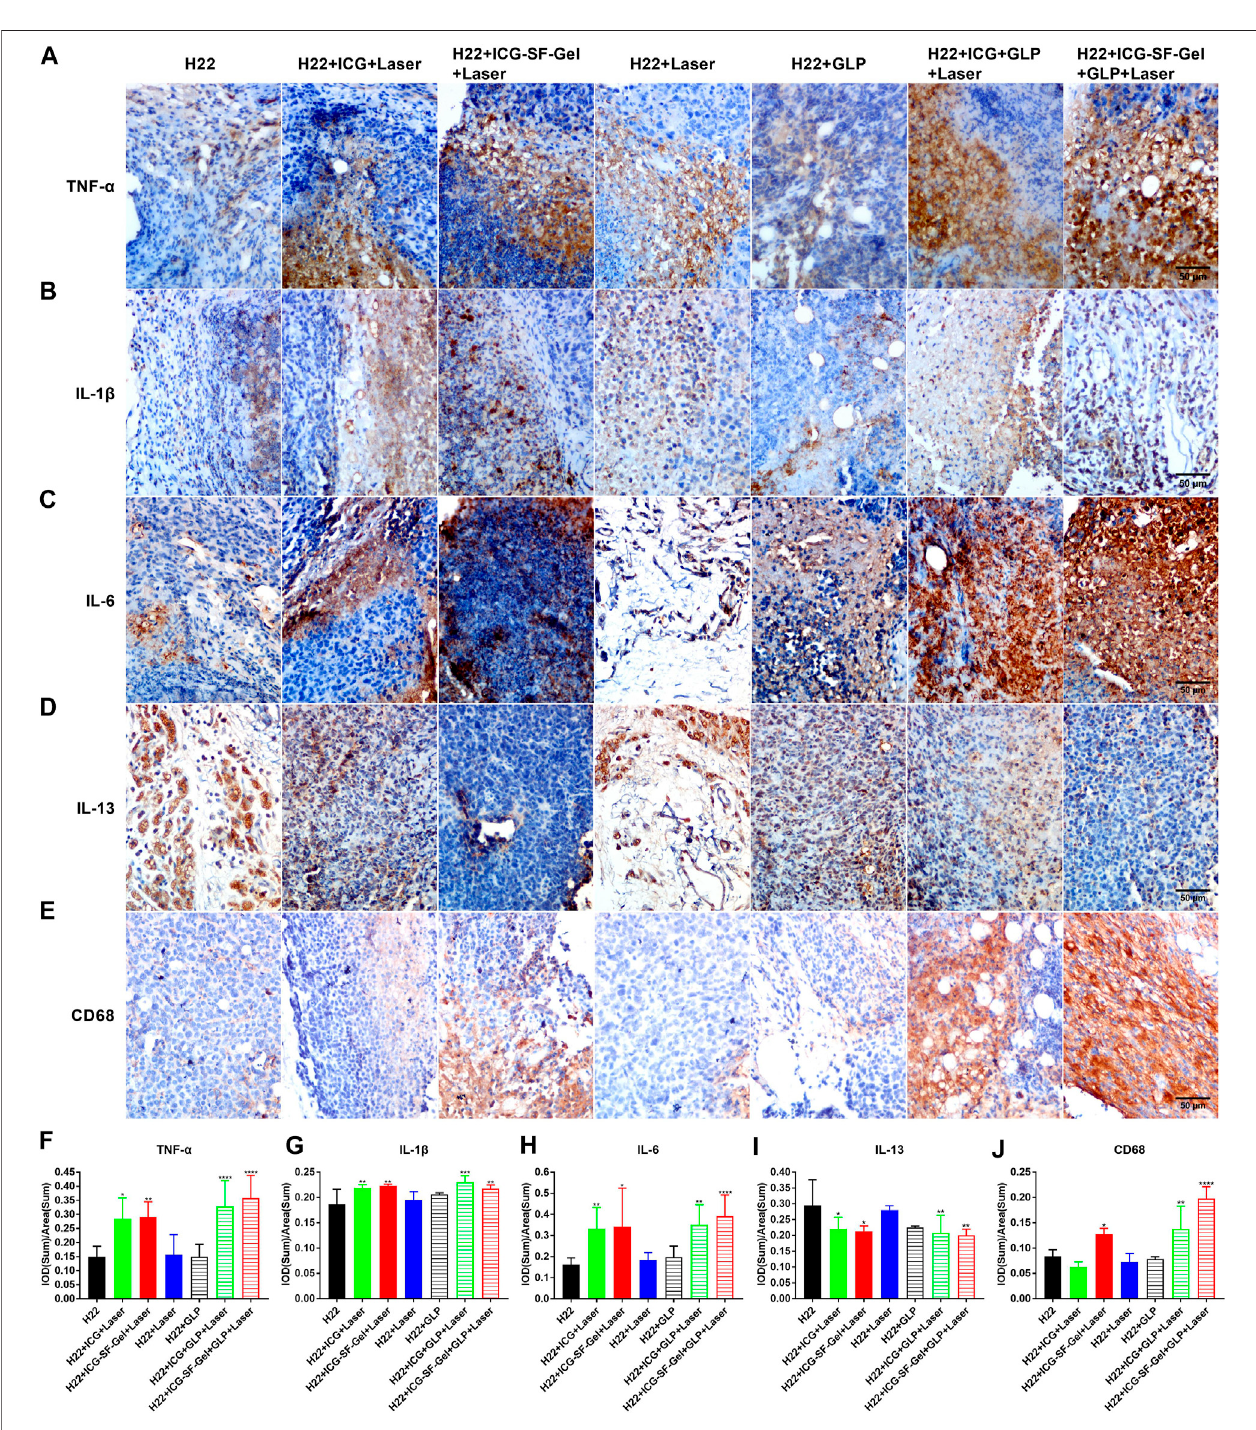
FIGURE 7 | The immune index of distal tumors after different treatments. (A – E) Immunohistochemical staining of TNF- α (A) , IL-1 β (B) , IL-6 (C) , IL-13 (D) and CD68 (E) of distal tumors collected from different treated groups ofmice 7 days after the distal tumor inoculation (The same row shared the same scale bar: 50 µm) and quantitative analysis of TNF- α (F) , IL-1 β (G) , IL-6 (H) , IL-13 (I) and CD68 (J) ( n (cid:2) 4 mice per group, data are presented as the mean ± SD. Statistical signi fi cance was expressed by * p < 0.05, ** p < 0.01, *** p < 0.001 and **** p < 0.0001, comparing other groups with the H22 group).